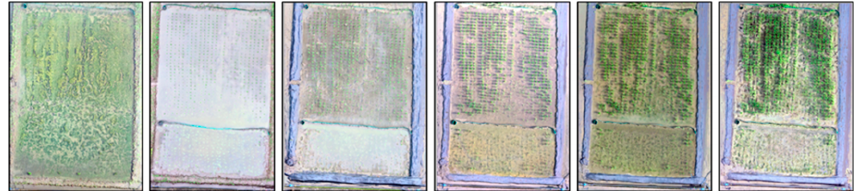
Figure 16. Low soil levels causing rice death in AWD-I in the second crop season.